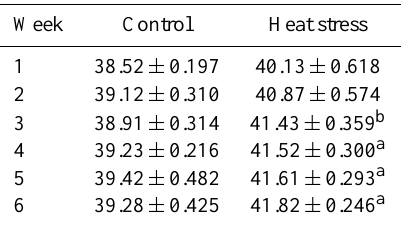
Figure 1. Effects of HS on FCR and weight of Wenchang chicks. Note: compared between CK and HS groups at the same age. ∗ P < 0 . 05; ∗∗ P < 0 . 01. Table 1. The Effects of HS on the rectal temperature of chicken ( n = 10).